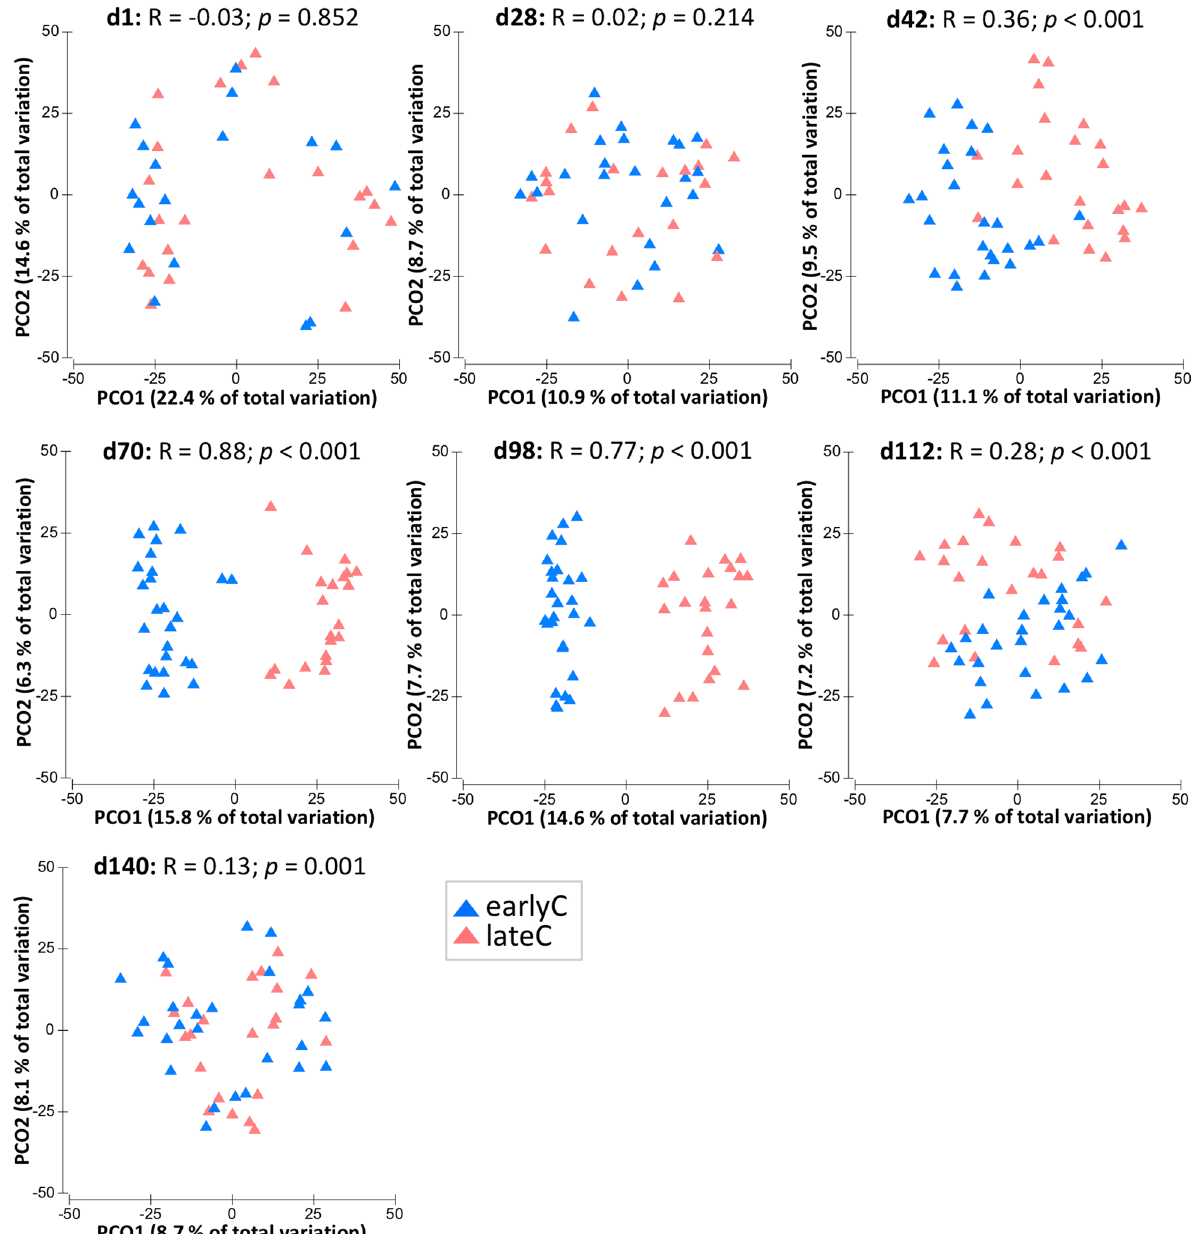
Fig. 2 Principal‑coordinate analysis plots showing changes in bacterial compositional profiles of faecal samples due to weaning event. Each triangle indicates one sample. The significant differences between same‑age‑old weaning groups, separated based on PCO analysis, were confirmed using analysis of similarities test (ANOSIM), with R‑ and p values